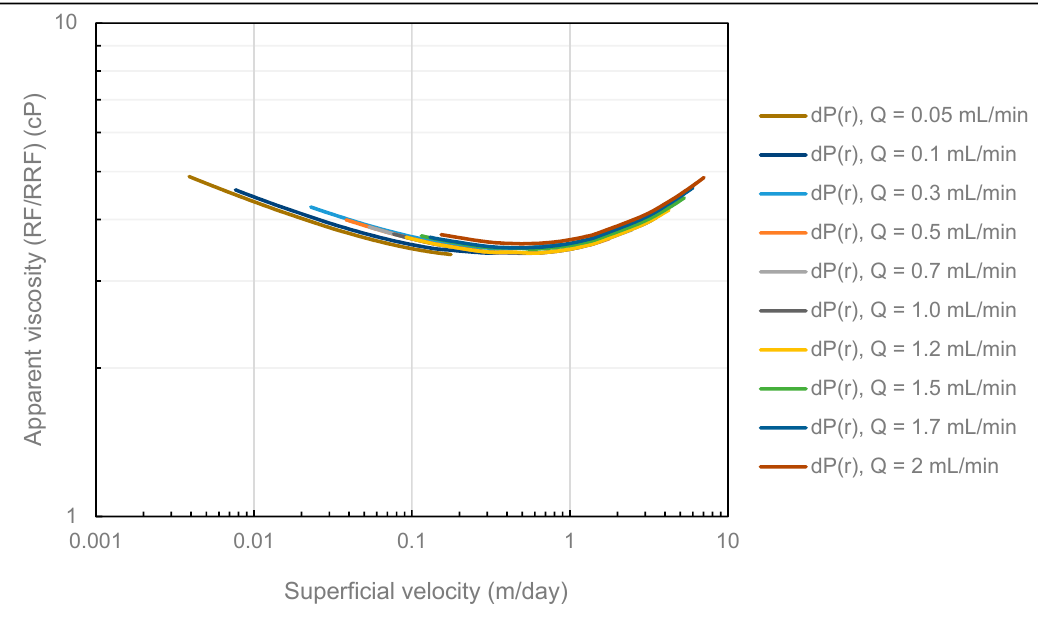
Figure 9. Summary of polymer in situ rheology obtained from both history match methods.